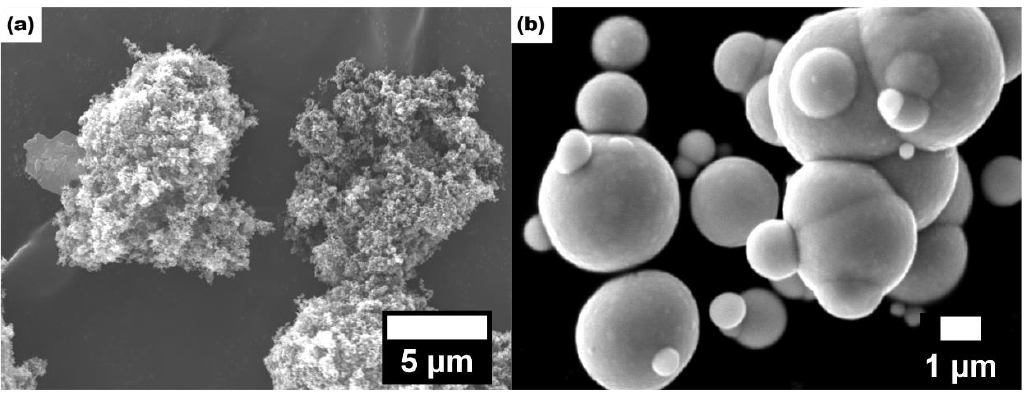
Figure 2. SEM micrographs of absorbent: ( a ) CB; ( b )